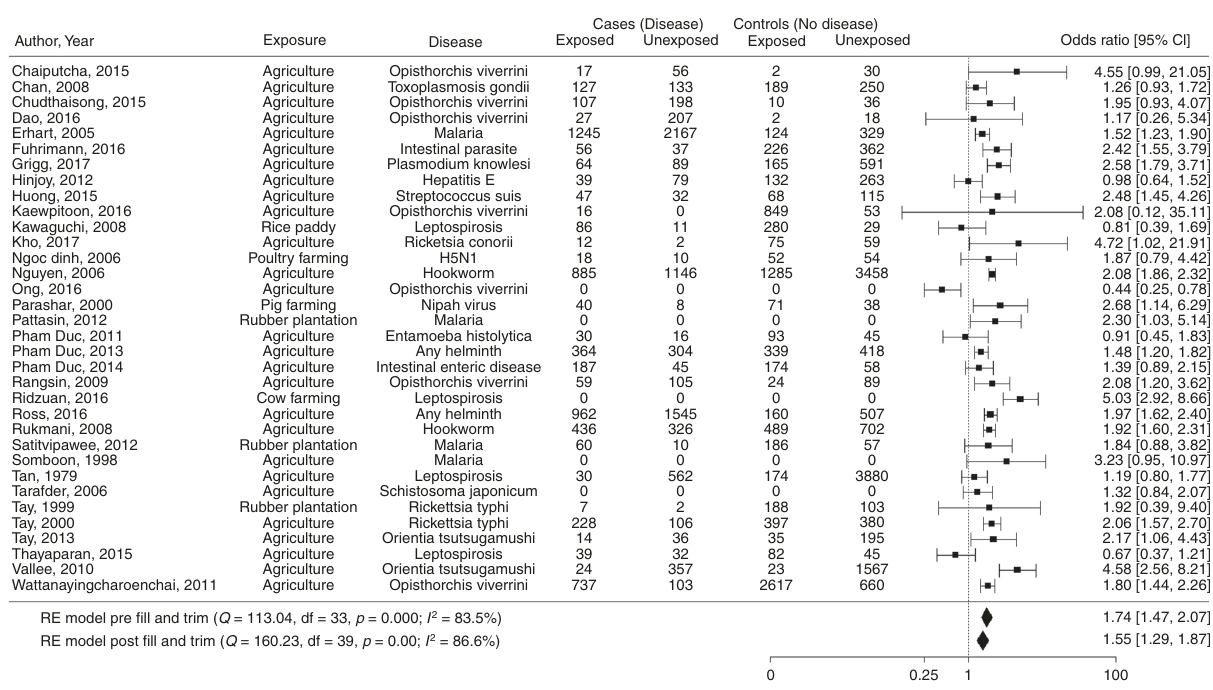
Fig. 2 Regional meta-analysis. Regional meta-analysis of mutually exclusive risk estimates to determine the association between occupational or residential exposure to agricultural land-use and infectious disease prevalence. Exposure to 'agriculture' is de fi ned as a category where a person indicates they work or live in or near agriculture regardless of the type of agriculture. Square points show the crude odds ratio for each study, solid diamonds show the pooled meta-analysis estimates and error bars are de fi ned as the 95% con fi dence interval. Note: Q , the Cochrane Q- test. Df, degrees of freedom. p , p -value. I 2 , test for heterogeneity. RE, random effects